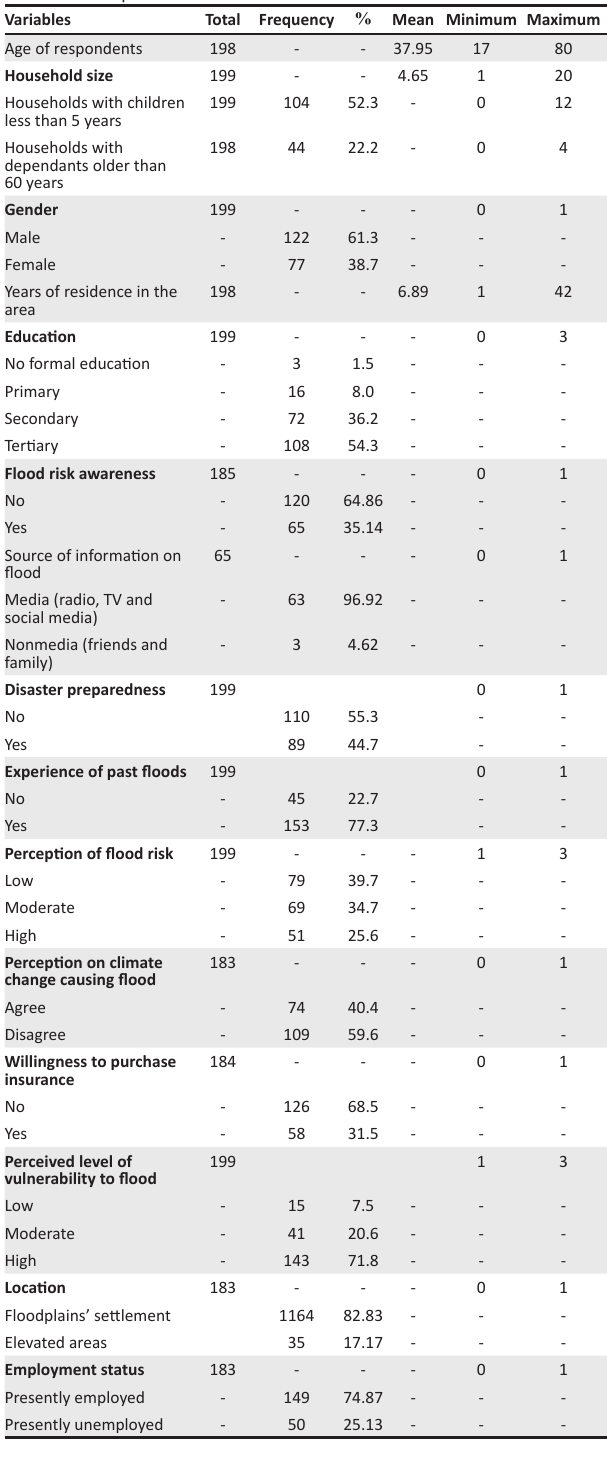
TABLE 3: Descriptive characteristics of the urban households.